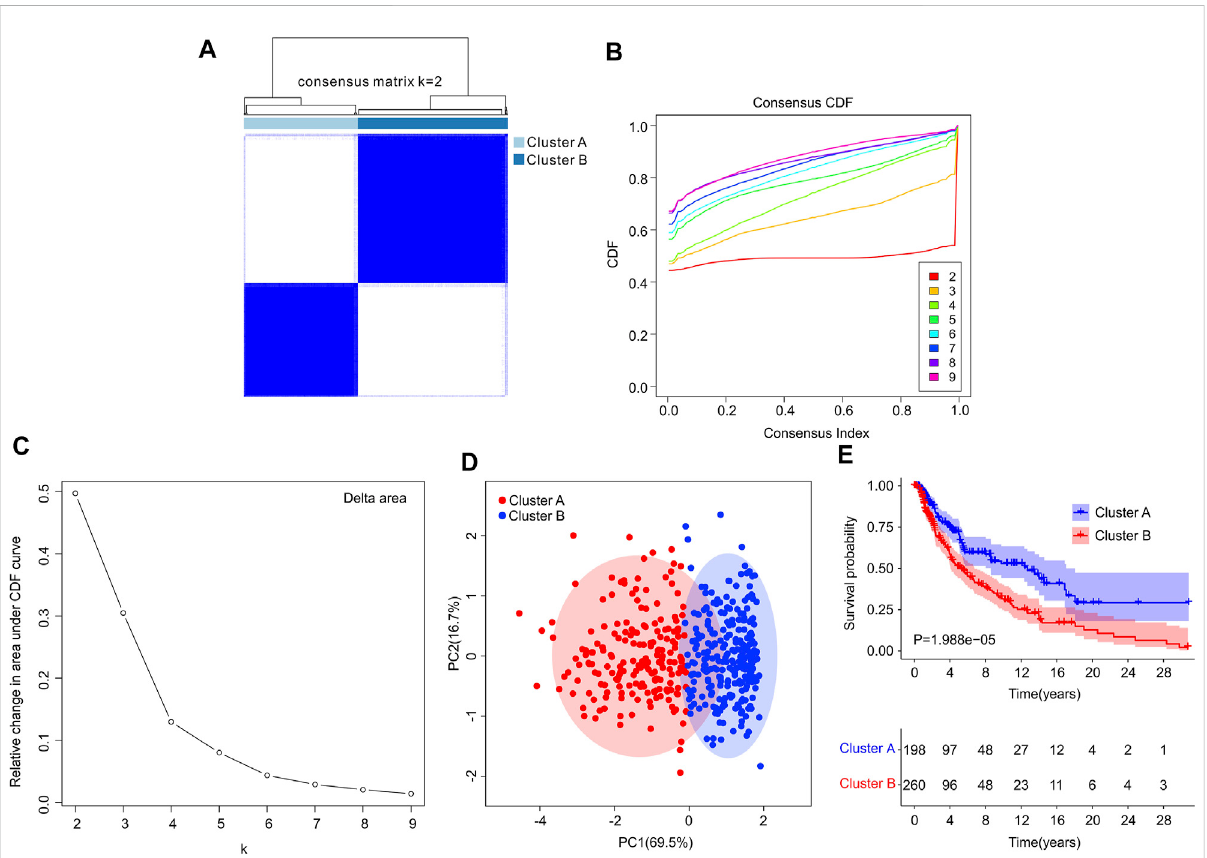
FIGURE 6 Consensus clustering analysis of CM patients based on the ICD-related genes. (A) Consensus clustering heatmap of group at k = 2. (B) Cumulativedistributionfunction (CDF)curvefork=2 – 9. (C) RelativechangeinareaunderCDFcurvefor k=2 – 9. (D) Principalcomponents analysis (PCA) shows a signi fi cant distribution pattern betweencluster A and cluster B. (E) The Kaplan-Meier survival curve analysis reveals that the OS rate of patients in Cluster A is higher than those in Cluster